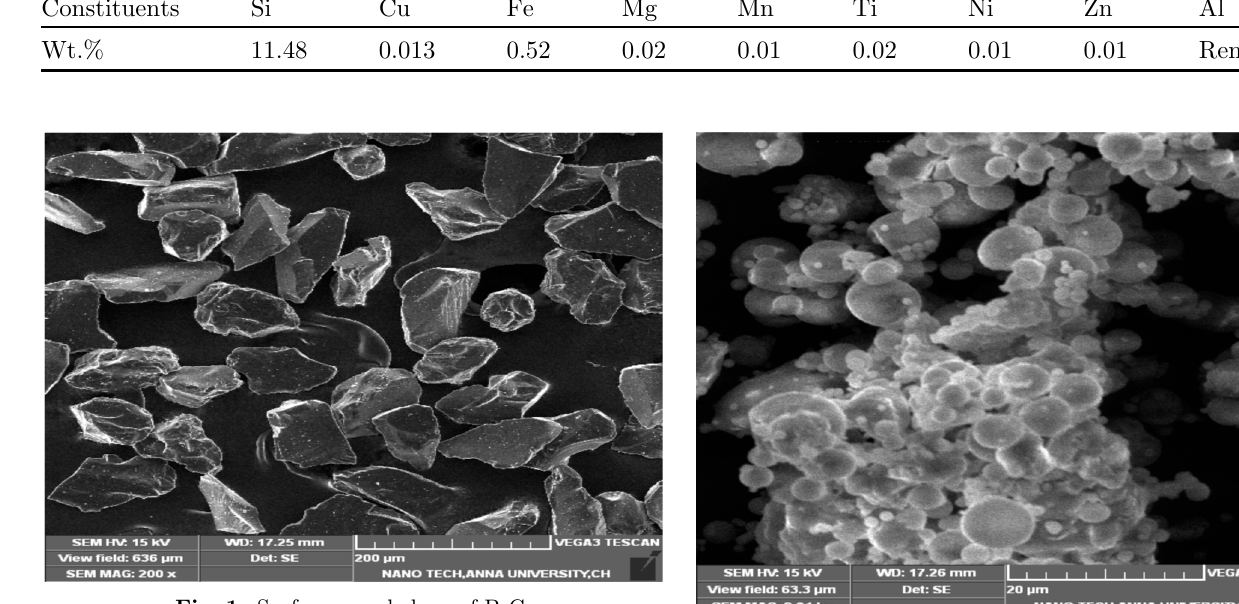
Fig. 1. Surface morphology of B 4 C.